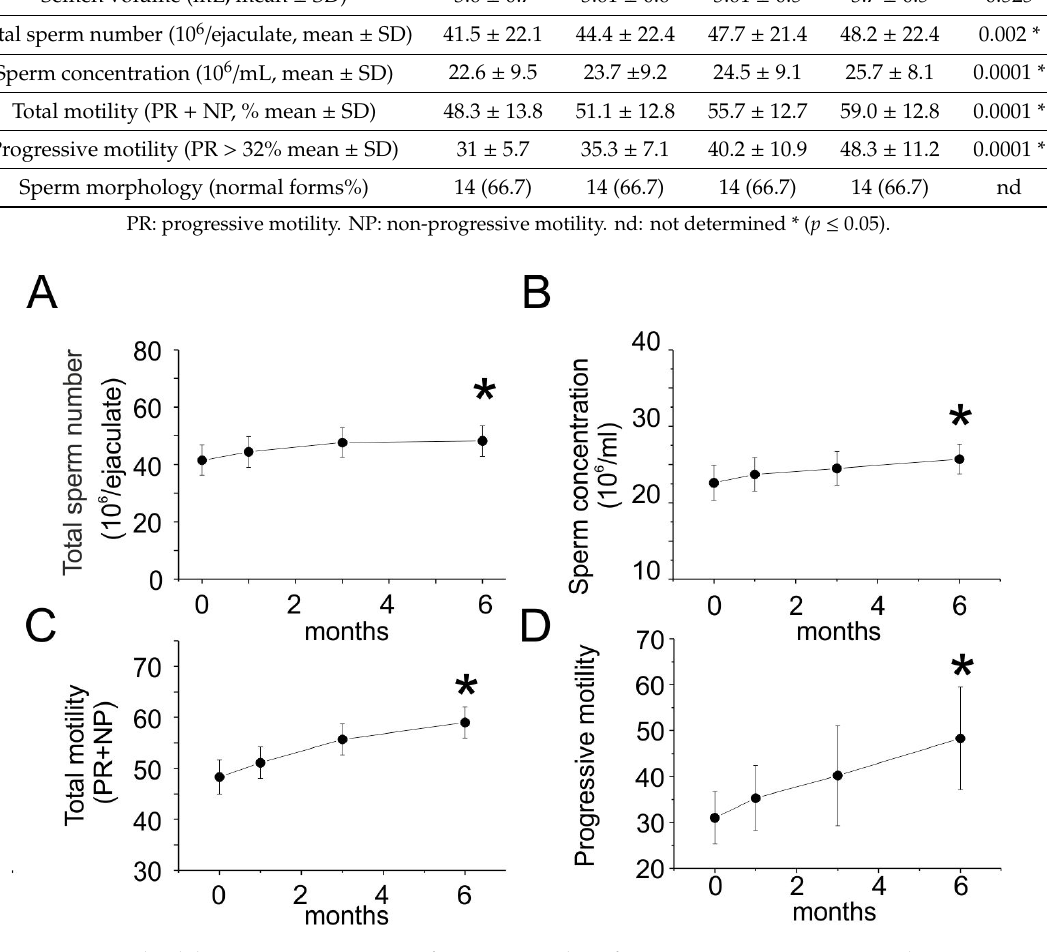
Figure 1. The laboratory assessment after six months of treatment. Data presented as ± SD. Significant differences between control and treated cells are denoted as * ( p ≤ 0.05). ( A ): change in the total number of spermatozoa in six months. ( B ): change in the sperm concentration in six months. ( C ): change in the total motility (PR+NP) in six months. ( D ): Change in progressive motility in six months. Table 2. Semen parameters at baseline 1, 3, and 6 months after recruitment.